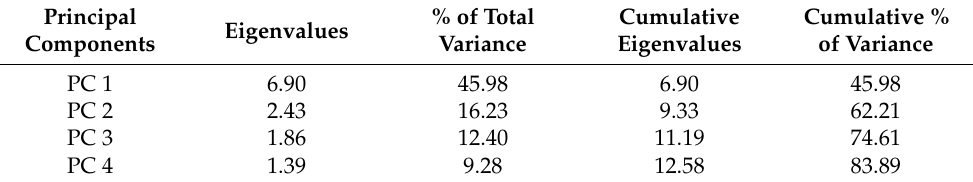
Table 3. Analysis of principal components for HA parameters.